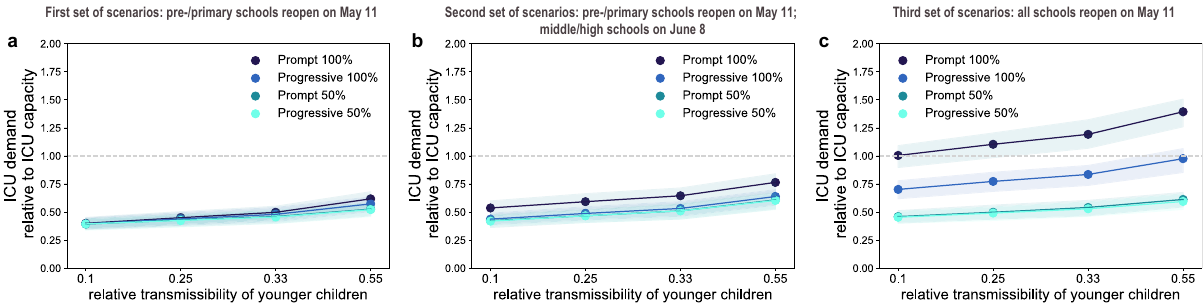
Fig. 6 Impact of reopening schools on ICU occupancy. a – c Projected ICU demand on August 1 relative to the foreseen 1500-bed ICU capacity in the region restored after the fi rst wave emergency, as a function of the relative transmissibility of younger children, for different reopening protocols. Results are obtained considering moderate social distancing interventions coupled with 50% case isolation. Shaded areas correspond to 95% probability ranges around the median value, obtained from n = 500 independent stochastic